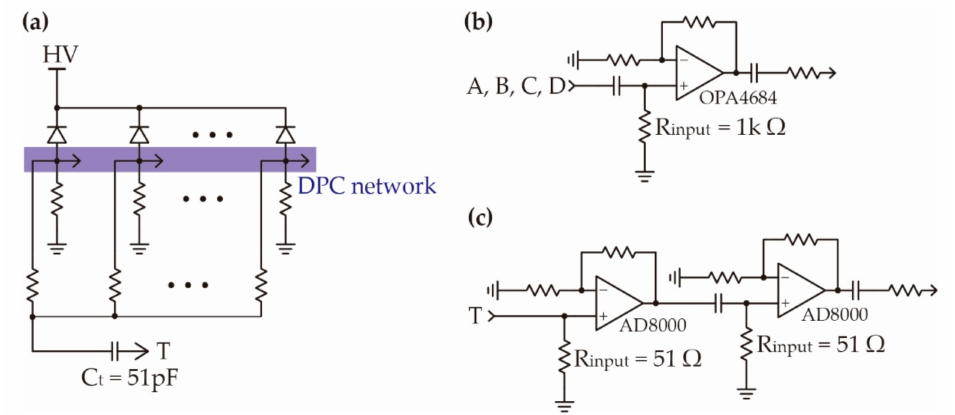
Figure 1. Detailed schematic of amplifier board. ( a ) Silicon photomultipliers (SiPM) biasing and signal path as an input for discretized positioning circuit (DPC) network and timing signal, respectively. ( b ) Non-inverting amplifier for generating position and deposited energy information. ( c ) Dual-stage non-inverting amplifier for generating trigger signal.